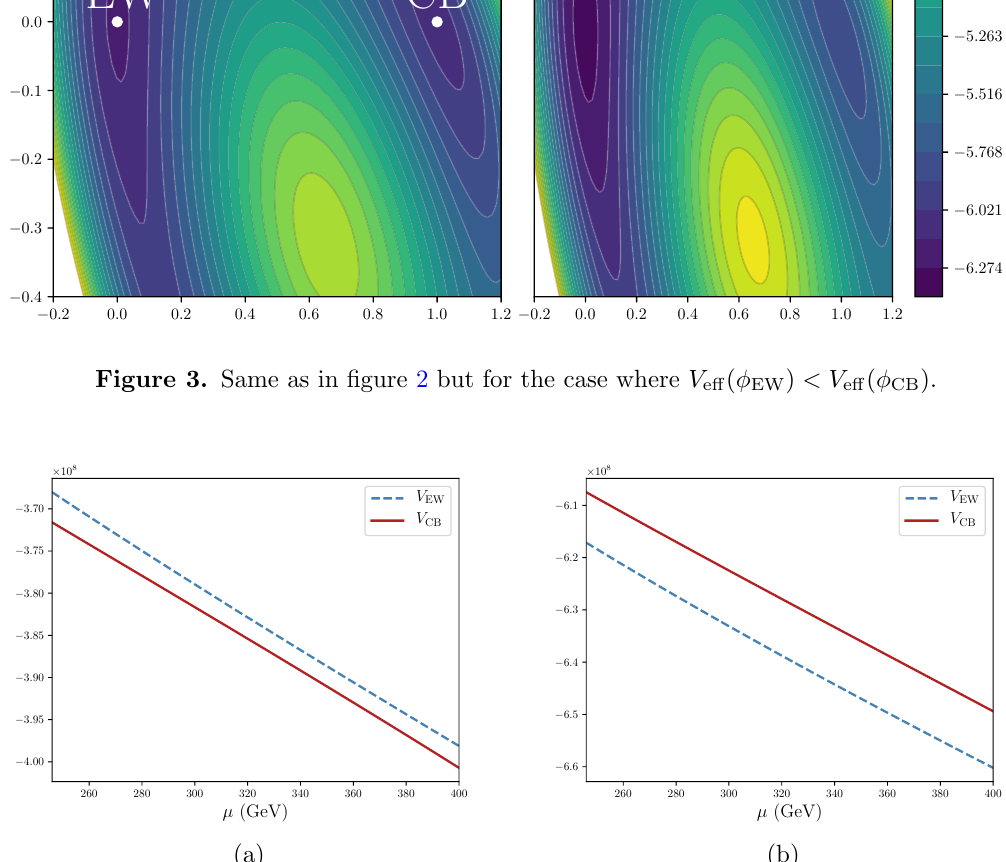
Figure 4. Running of the values of the e(cid:11)ective potential evaluated at its EW and CB minima for the case where V e(cid:11) ( (cid:30) CB ) < V e(cid:11) ( (cid:30) EW ) (left) and V e(cid:11) ( (cid:30) EW ) < V e(cid:11) ( (cid:30) CB ) (right). These plots demonstrate that our results are independent of the particular choice of renormalization scale that we